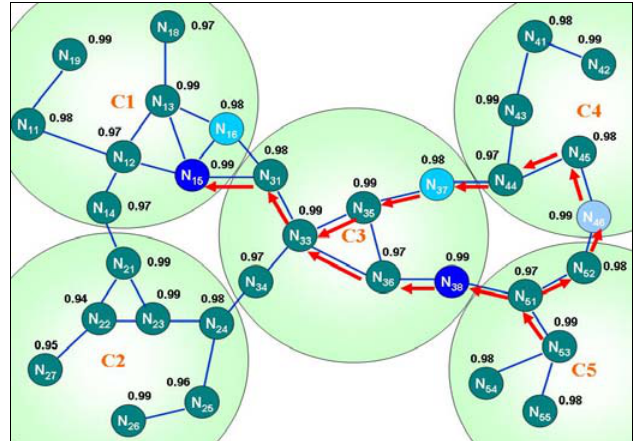
Figure 12. Inter-cluster routing.